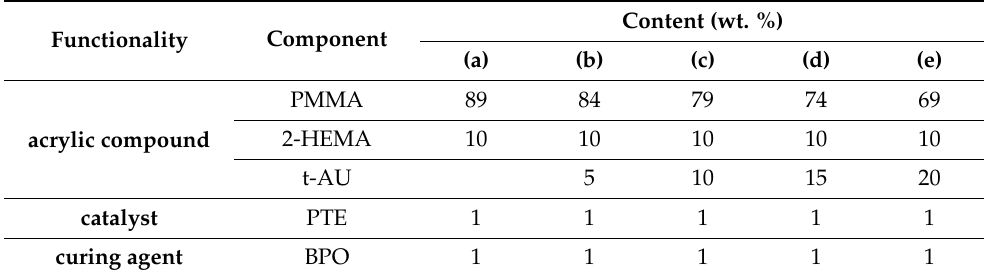
Table 1. Split composition of the comparative